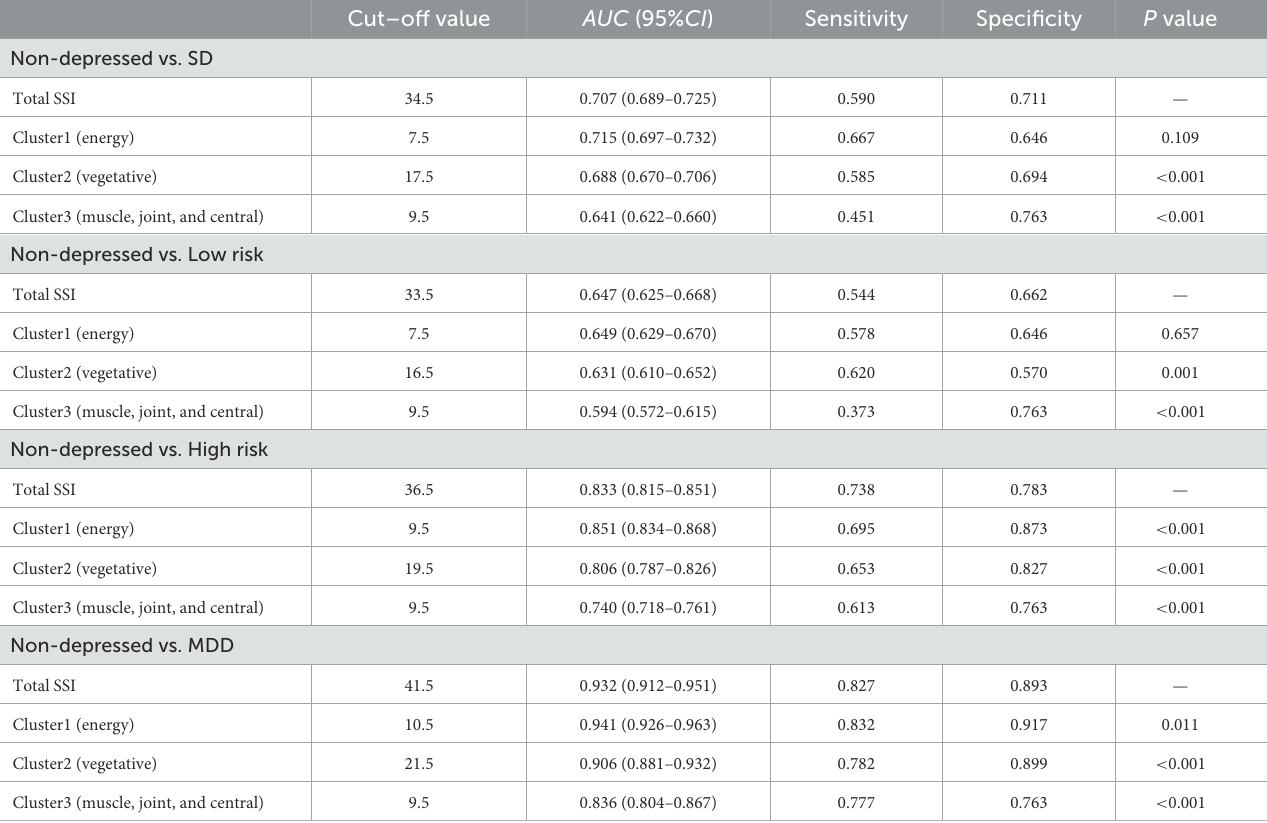
TABLE 4 Receiver operating characteristic analysis of total SSI score and different Clusters scores in identifying SD and MDD. Cut–off value